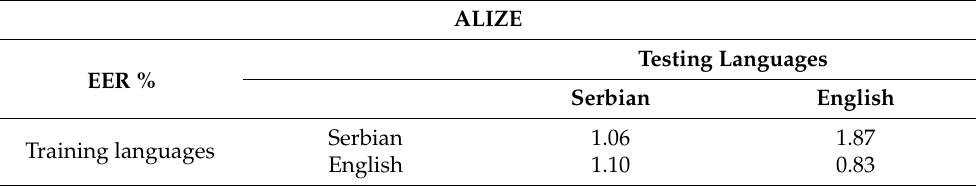
Table 4. The best ALIZE performance, as measured by EER, compared to the languages used.